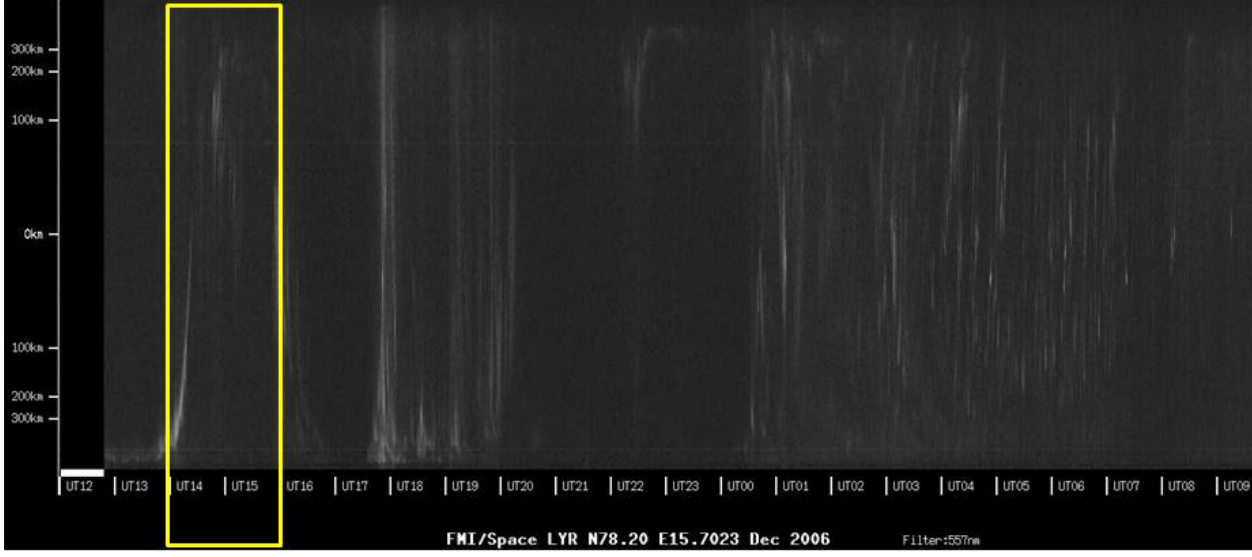
Fig. 14. FMI keogram for the night of 23 December 2006 showing how the aurora moves from south of Svalbard to the north during the period 14:00–15:00UT corresponding to the change in the success of the match between SCANDI and FPI measurements of T n due to the signal to noise ratio.